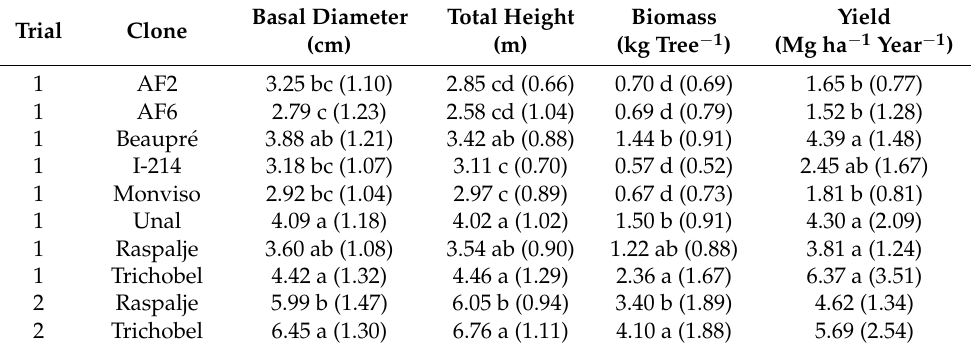
Table 3. Size and dry matter biomass yield (with standard deviations) of different clones evaluated in trials 1 and